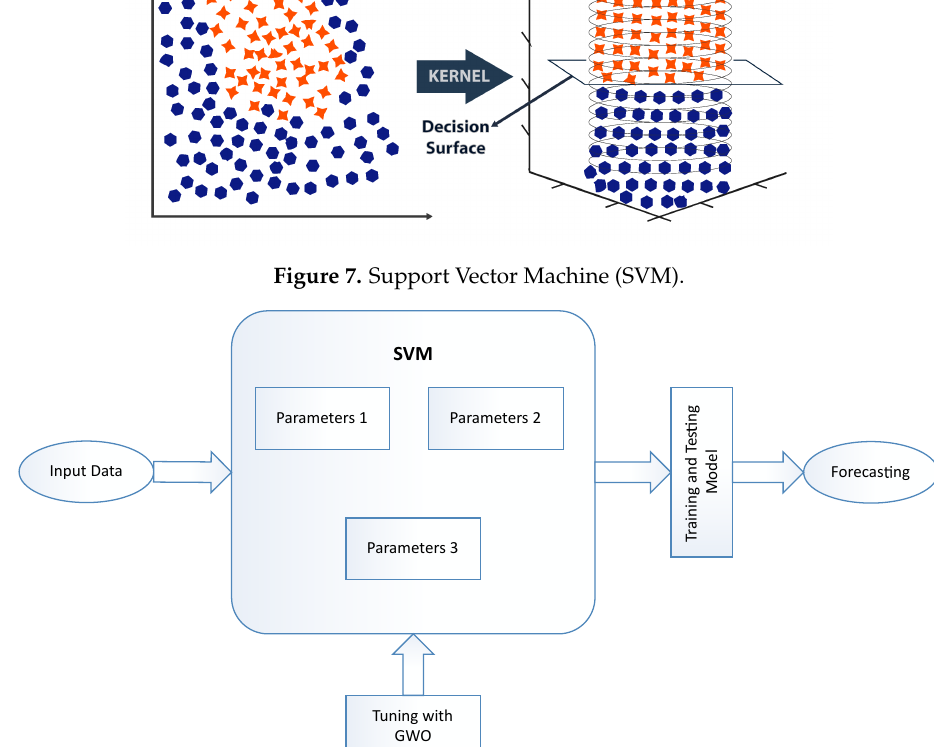
Figure 8. SVM-Grey Wolf Optimization